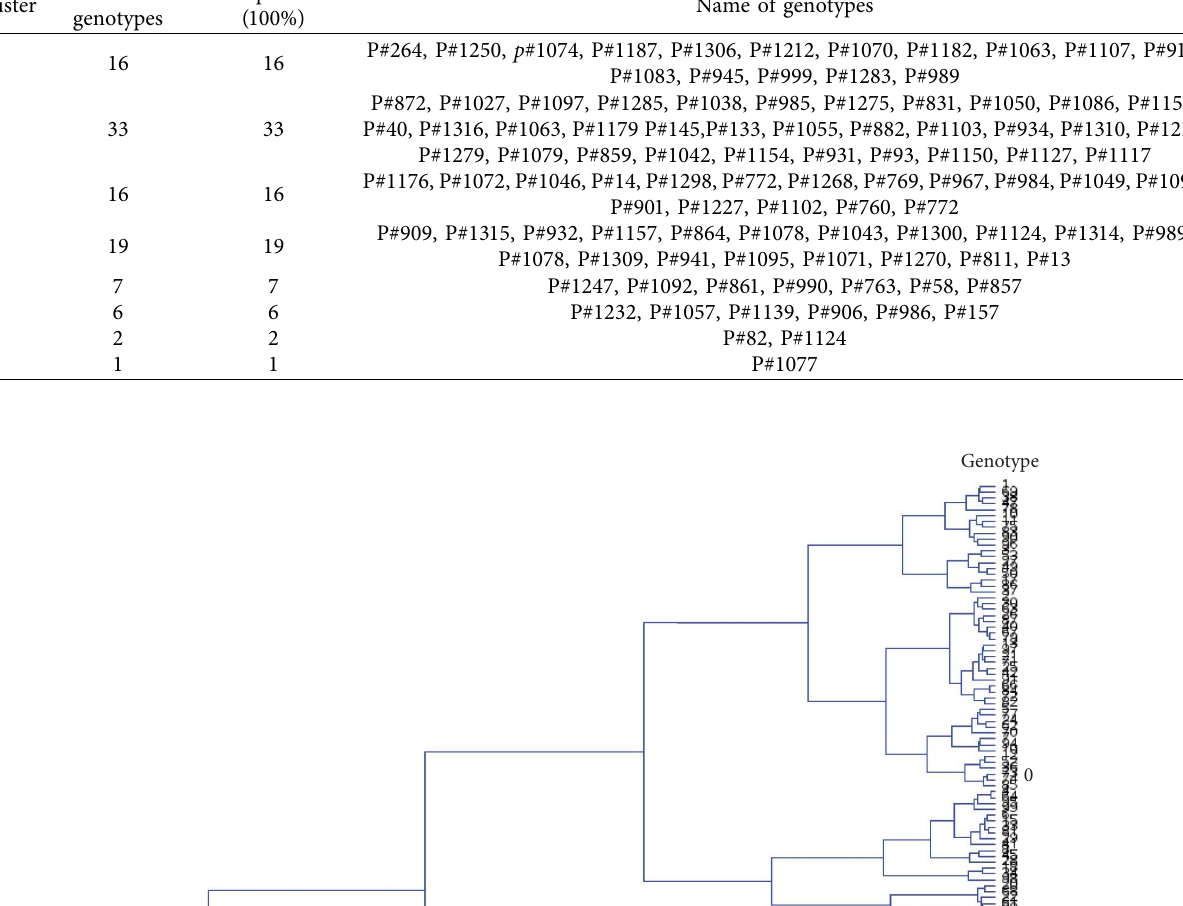
Table 8: Te cluster of 100 common bean genotypes based on the qualitative traits under study (2020/21). No. of Cluster genotypes